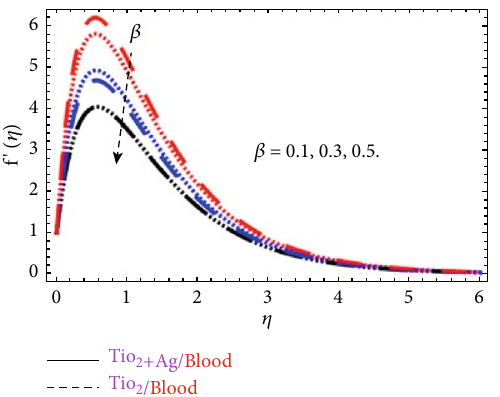
Figure 4: Inspiration of porosity parameter φ on velocity pro fi